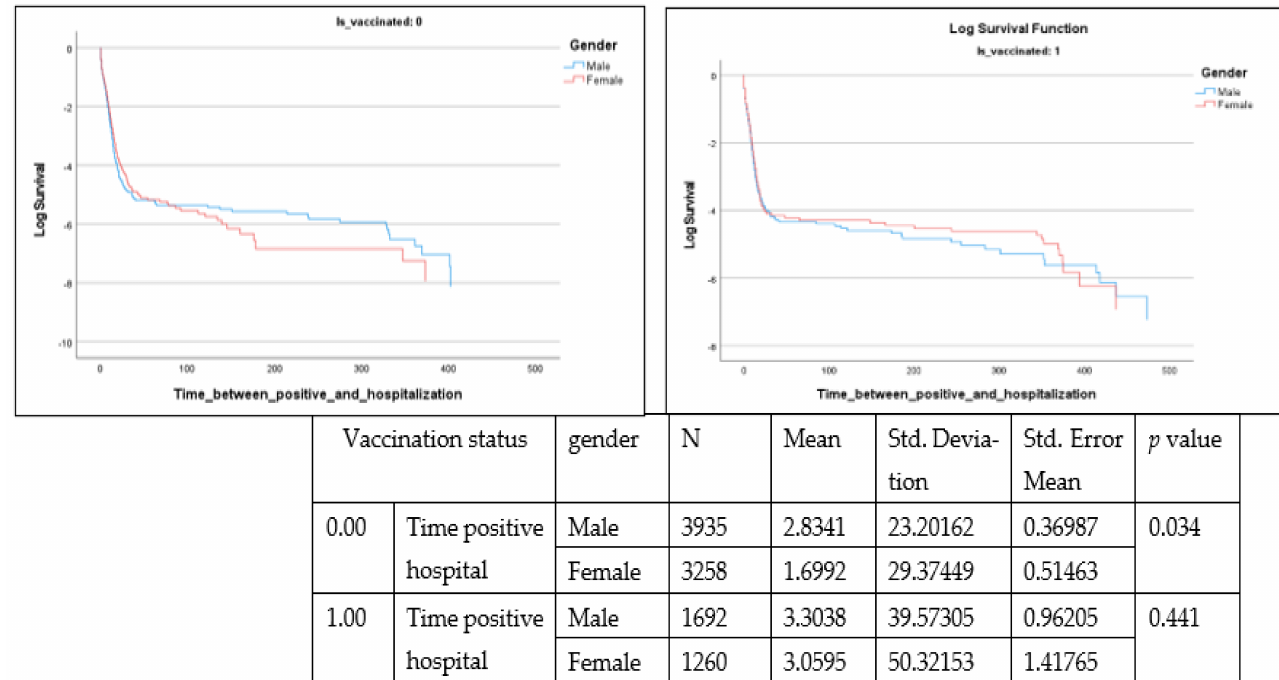
Figure 5. Time from positive diagnosis to hospital admittance ((Is vaccinated 1 = vaccinated with at least one